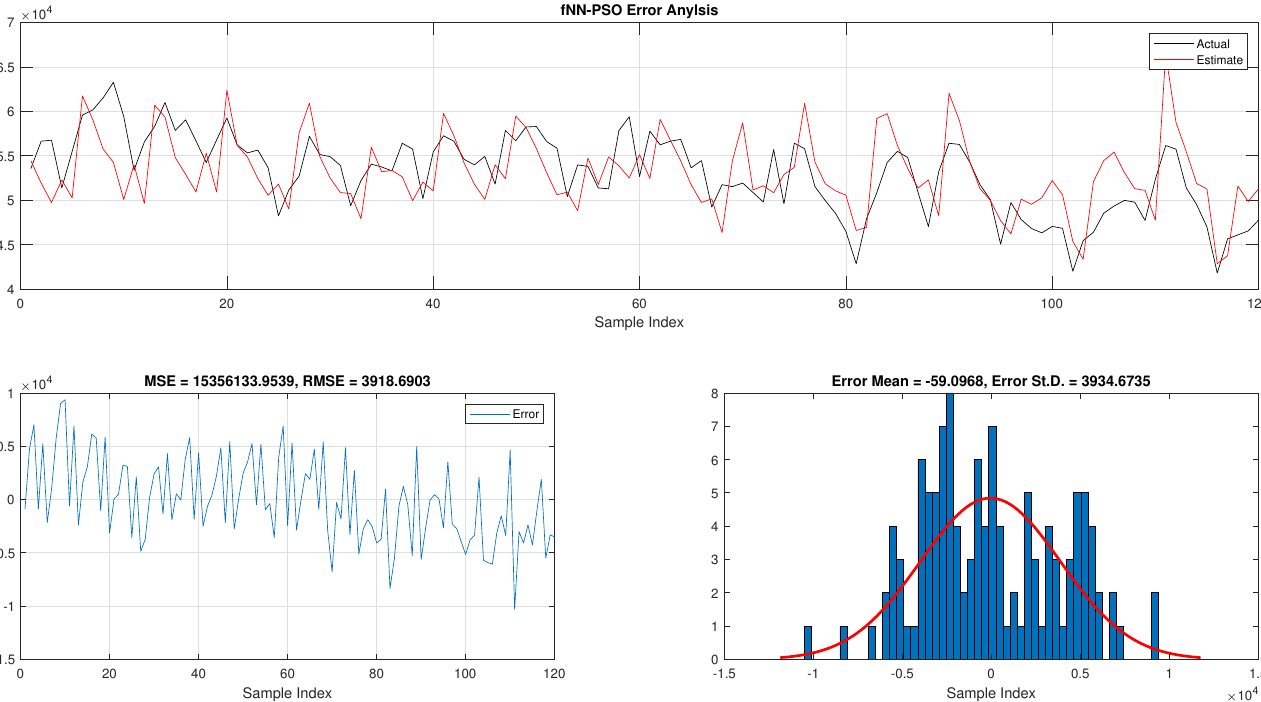
Figure 16. Error analysis of the total daily load consumption with fNN-GA best results.